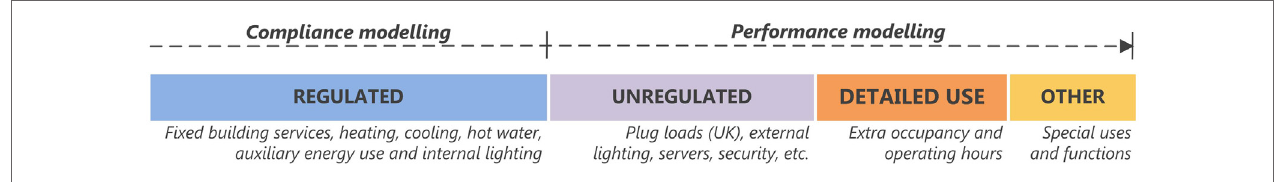
FiGURe 1 | Representation of compliance modelling and its exclusion of different end-uses in energy calculations of a